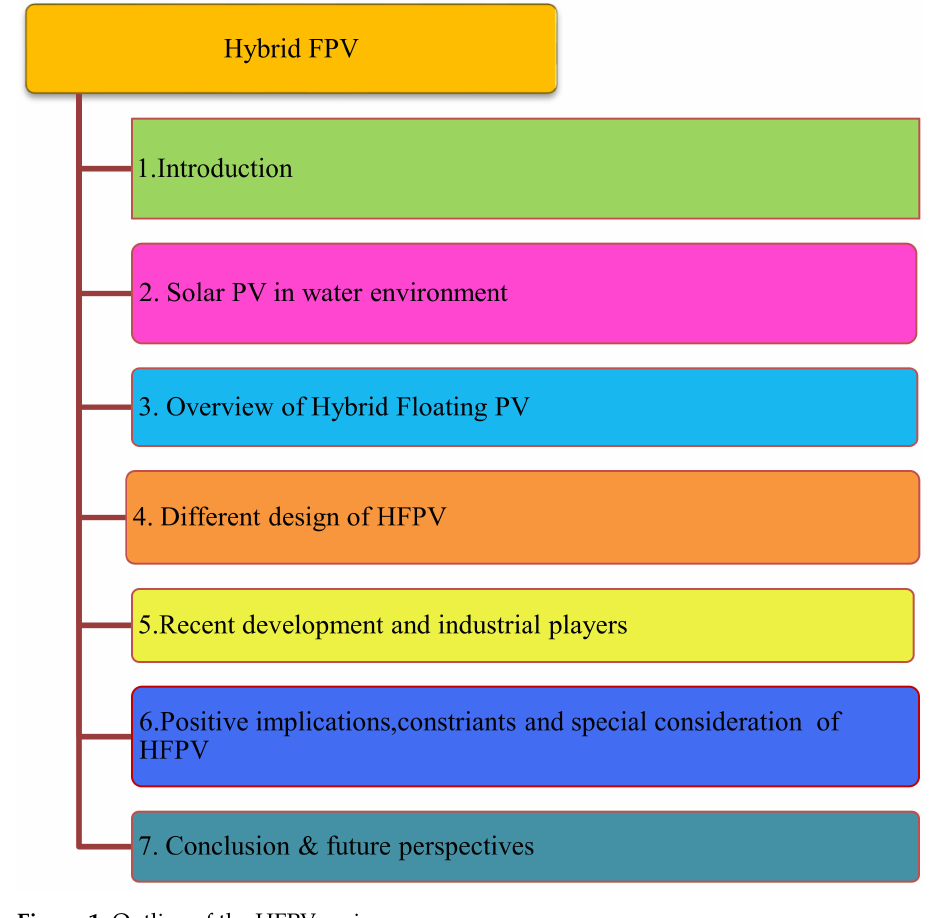
Figure 1. Outline of the HFPV